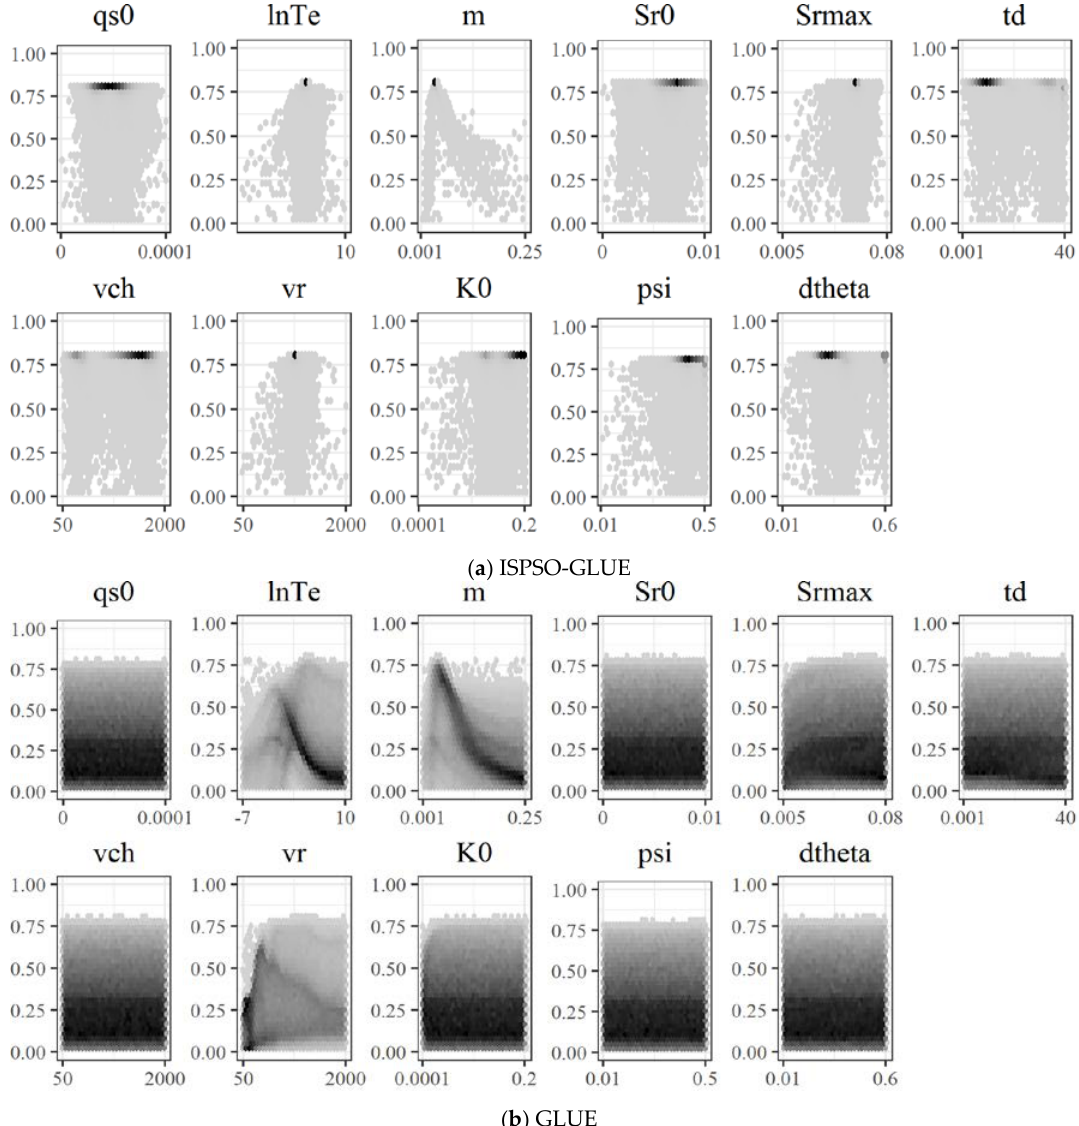
Figure 5. Hexagonal bin plots of NS vs. model parameters for ISPSO-GLUE and GLUE for the 5-year calibration period. Darker hexagons represent a higher density of samples.